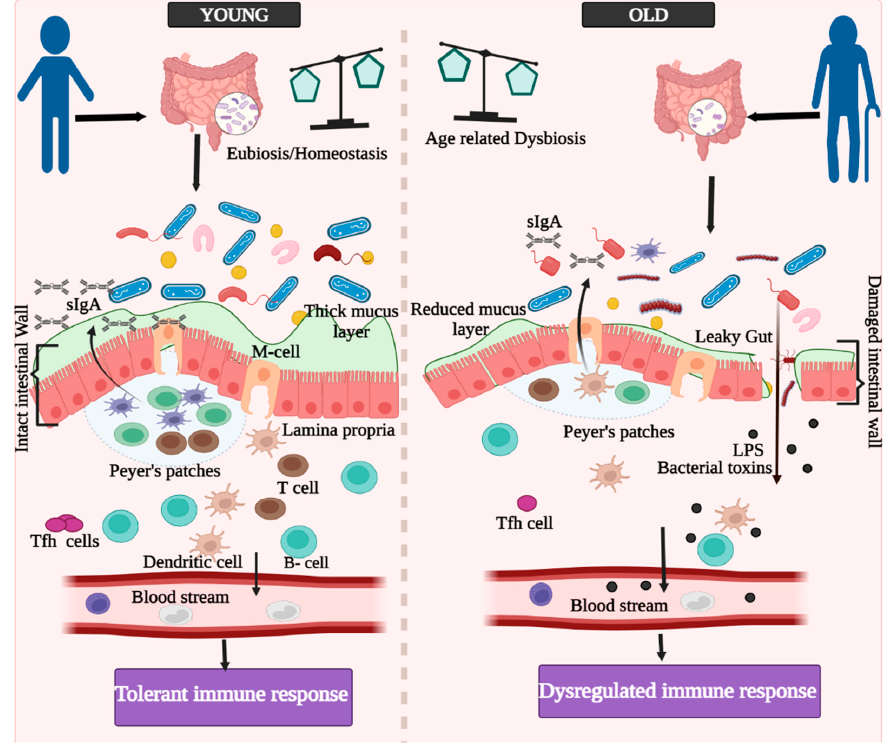
Figure 2. Aging-associated gut dysbiosis and GALT-associated immune responses in the elderly with ‘leaky’ gut. Tfh: T-follicular helper cells; LPS: lipopolysaccharide; sIgA: secretory immunoglobulin A.